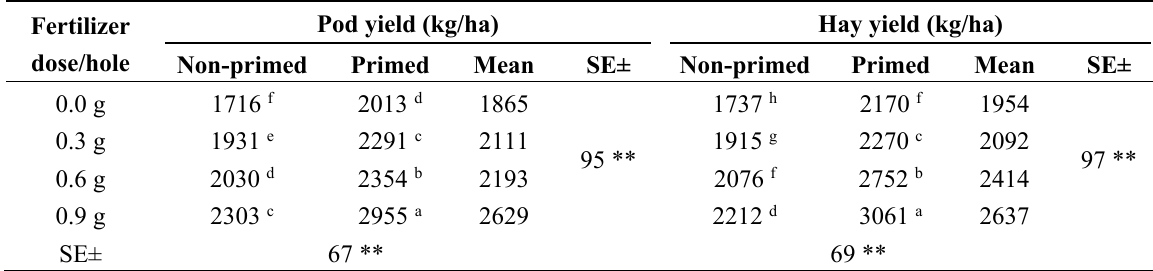
Table 5. Effect of seed priming and micro dosing on groundnut pod and hay yields (kg/ha) combined across two